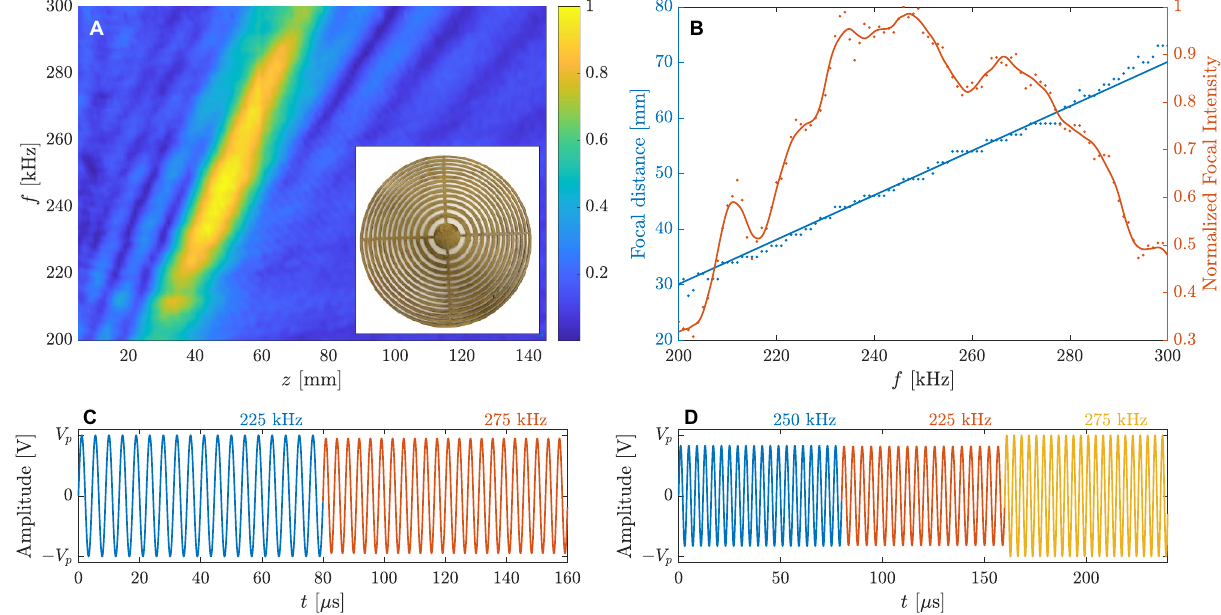
Figure 1. Time-modulation design technique: ( A ) measured axial spectrum of the Fresnel Zone Plate lens and ( B ) focal distance (left) and normalized focal intensity (right) as a function of the operating frequency. ( C ) Waveform designed to achieve two equal intensity foci at 40 and 60 mm and ( D ) waveform designed to achieve three foci at 50, 40, and 60 mm with normalized intensities 0.8, 0.6, and 1, respectively. In ( B ), solid dots correspond to experimental measurements while solid lines correspond to a linear fit to the data (blue) and a Savitzky–Golay interpolation filter